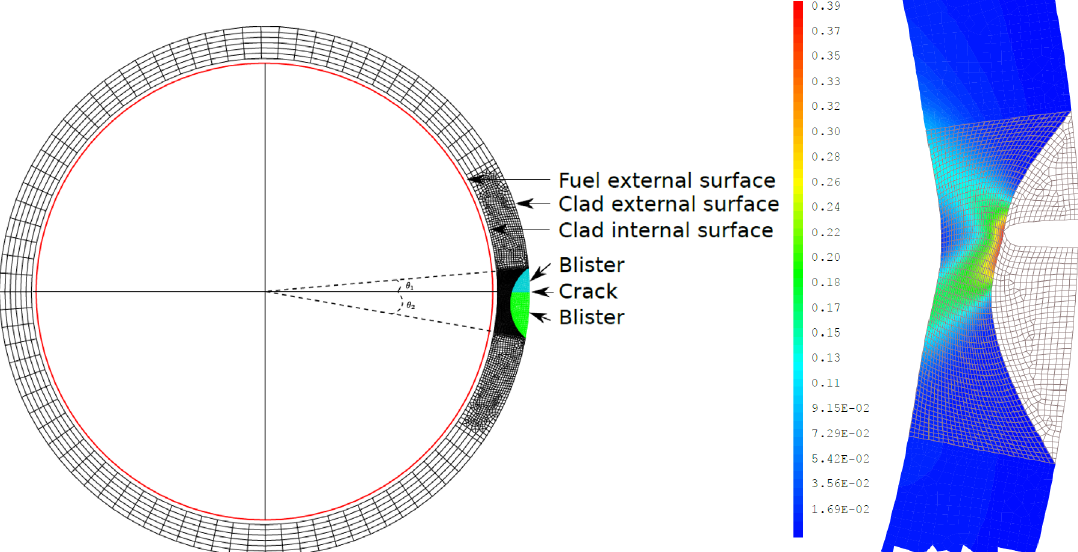
Fig. 10. Finite Element mesh of the 2D simulation of the whole cladding circumference with a single dissymetrically cracked blister. Calculated distribution of equivalent plastic strains in the simulation.